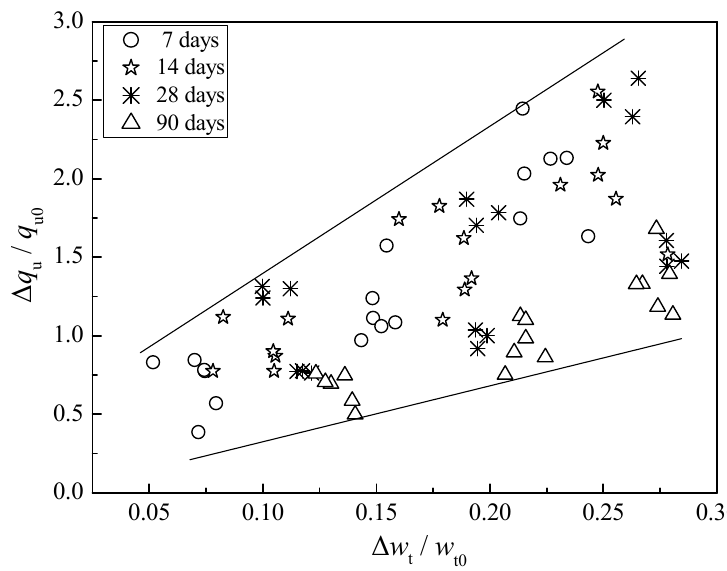
Figure 7. Effect of water absorption on strength increase.